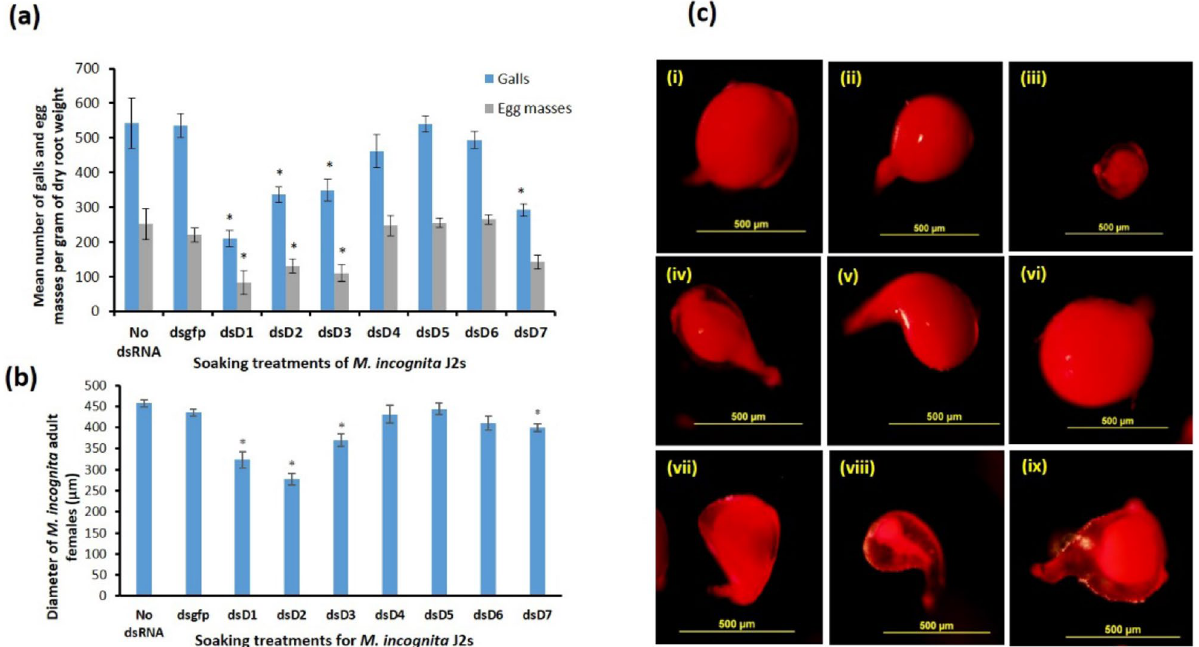
Figure 6. Infectivity and development of dsRNA-treated J2s on tomato seedlings. (a) Bars are means (n = 7) with standard errors of the number of galls and egg masses per gram of dry root weight of infected plants. (b) Mean diameter with standard errors (n = 14 to 25) of adult females dissected out of tomato roots seven weeks after inoculation with treated J2s. Note: One outlier was removed from the dsgfp data before statistical analysis; it was 395 µm in diameter. (c) Representative acid fuchsin-stained females isolated from tomato roots seven weeks after inoculation with J2s previously treated with (i) buffer without dsRNA (ii) dsgfp (iii) dsD1 (iv)